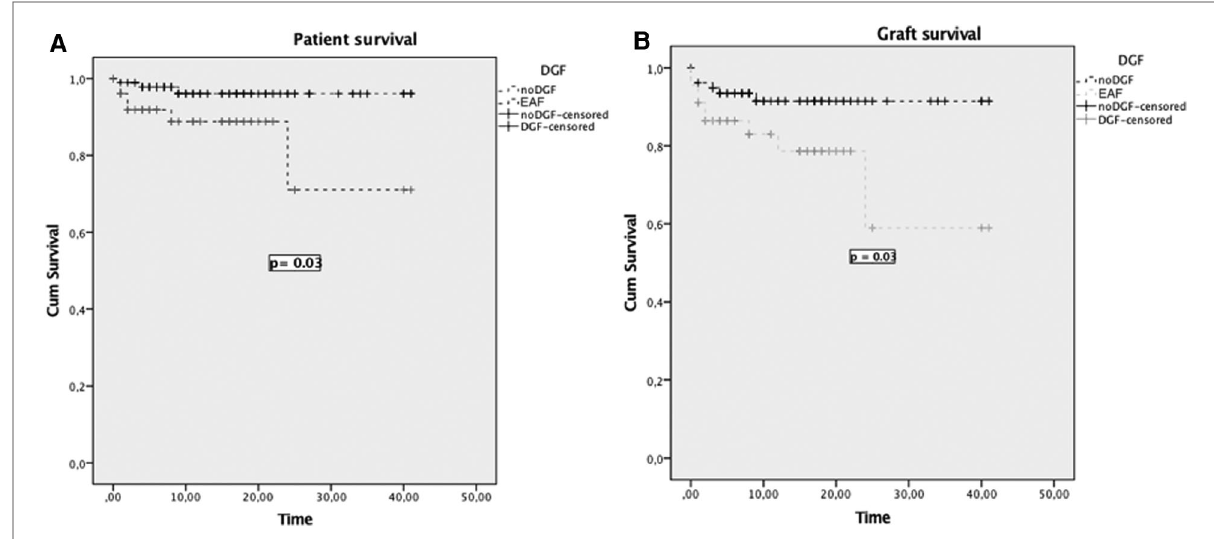
FIGURE 3 Patient ( A ) and graft survival ( B ) curves for patients who developed EAD and patients who did not